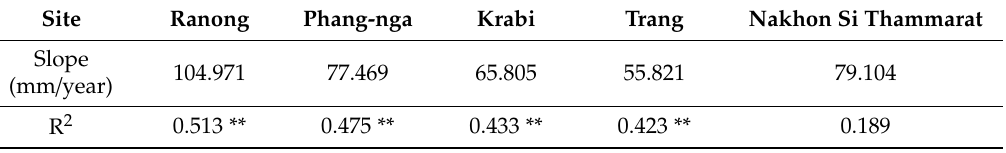
Figure A1. Accumulated annual rainfall of the five mangrove sites. Table A1. Statistics of accumulated annual rainfall trends.